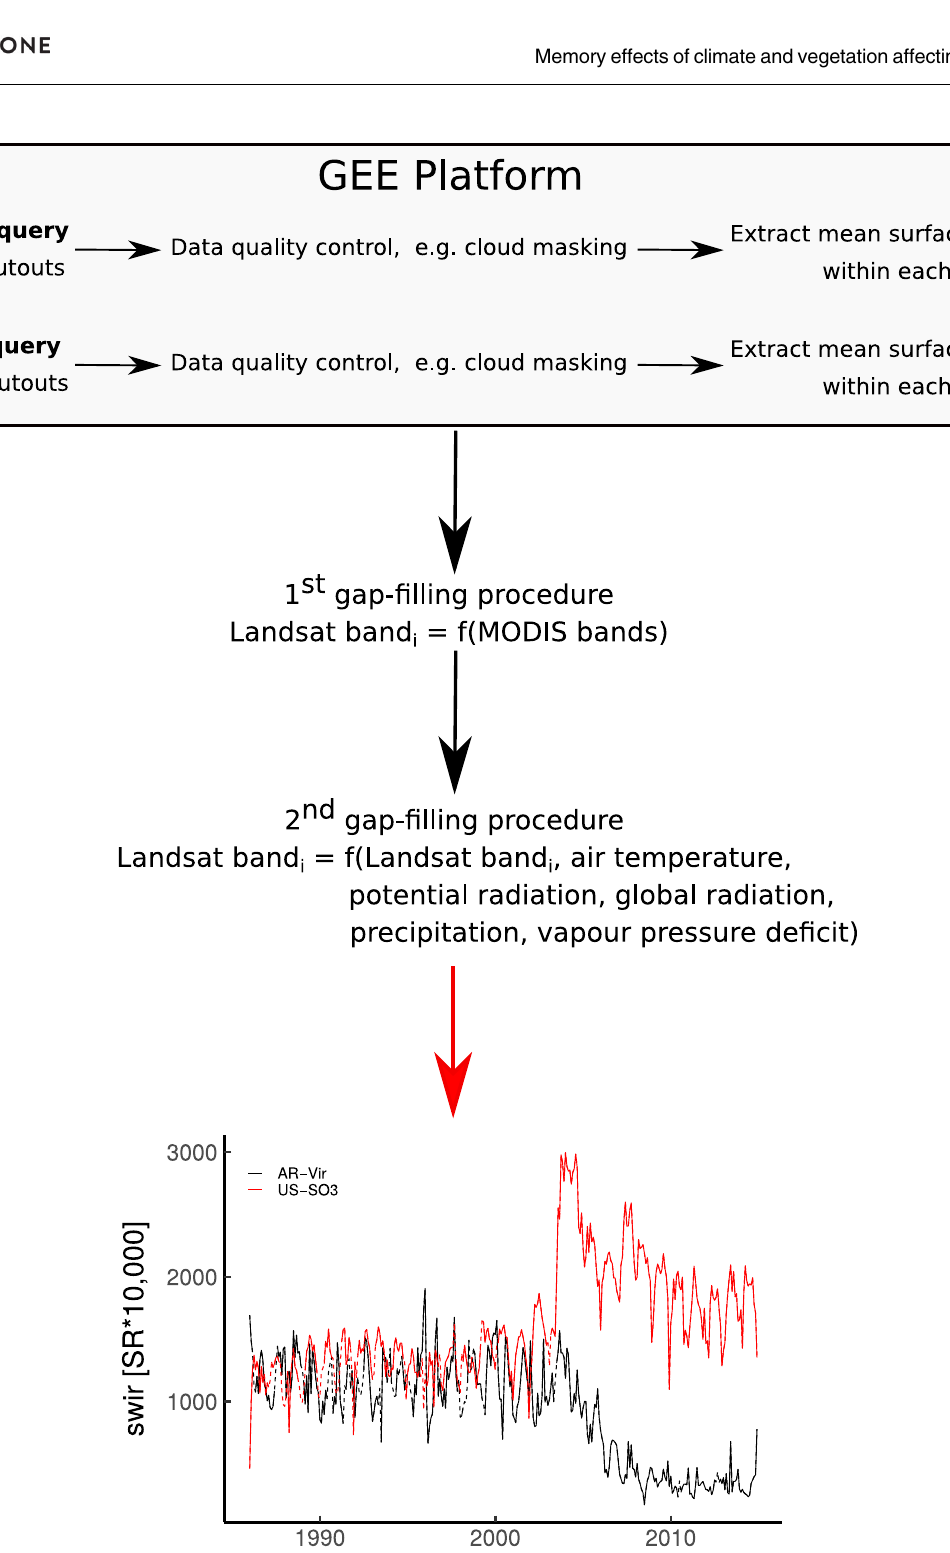
Fig 1. Flowchart of the Landsat data extraction and post-processing. SWIR = Shortwave Infrared. SR = Surface Reflectance. Monthly temporal gap-filled Landsat time series from 1982 to 2015 of the shortwave Infrared band are shown for AR-Vir and US-SO3 sites where, respectively, afforestation-reforestation and fire followed by a regrowth were reported in 2003. The solid and the dashed lines depict the real observations and the gap-filled data, respectively.